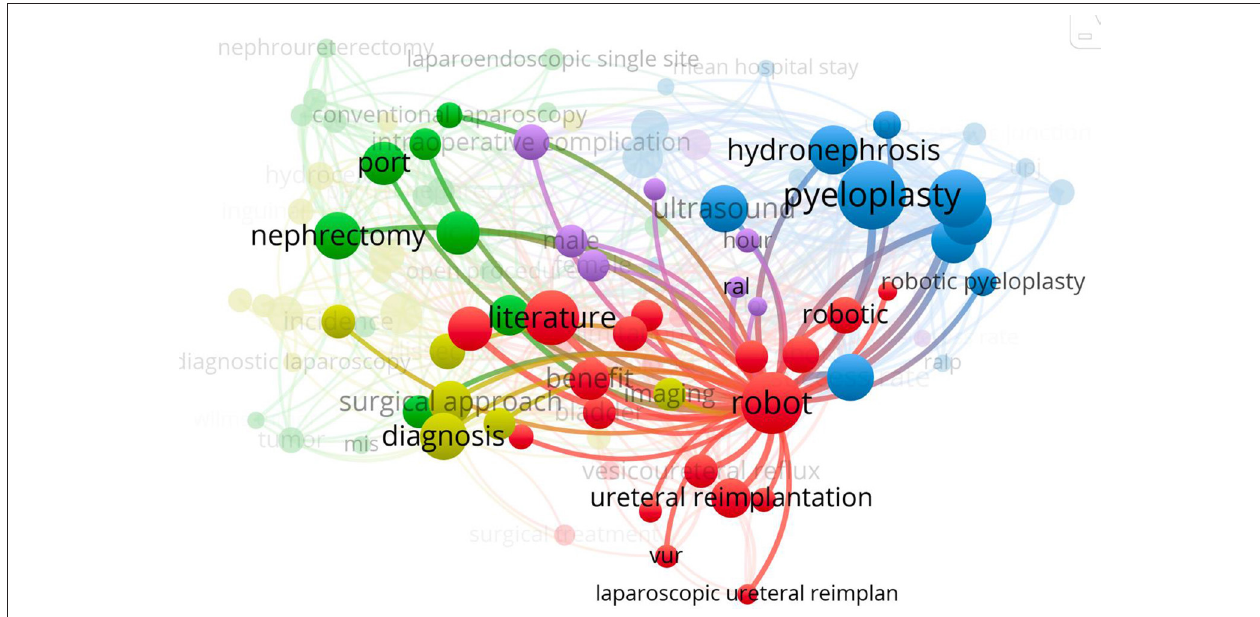
FIGURE 3 | Most discussed topics for manuscripts published in laparoscopy and robot-assisted pediatric